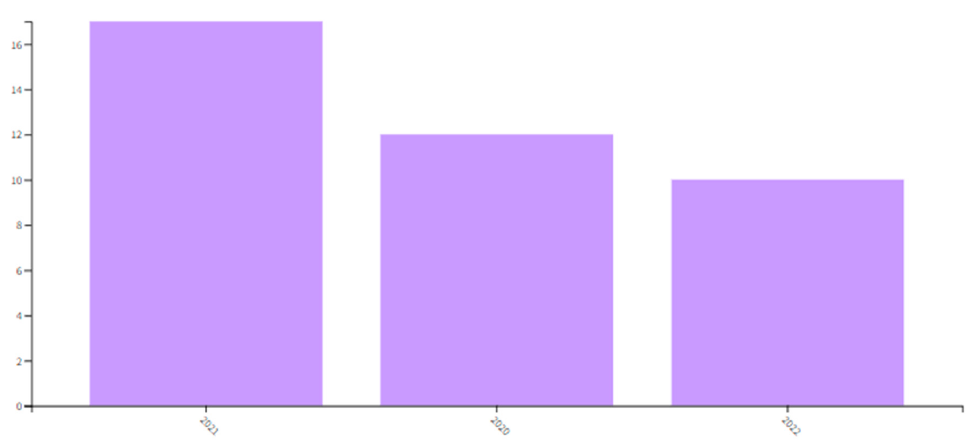
Figure 5. Evolution of the number of publications per year—Web of Science.